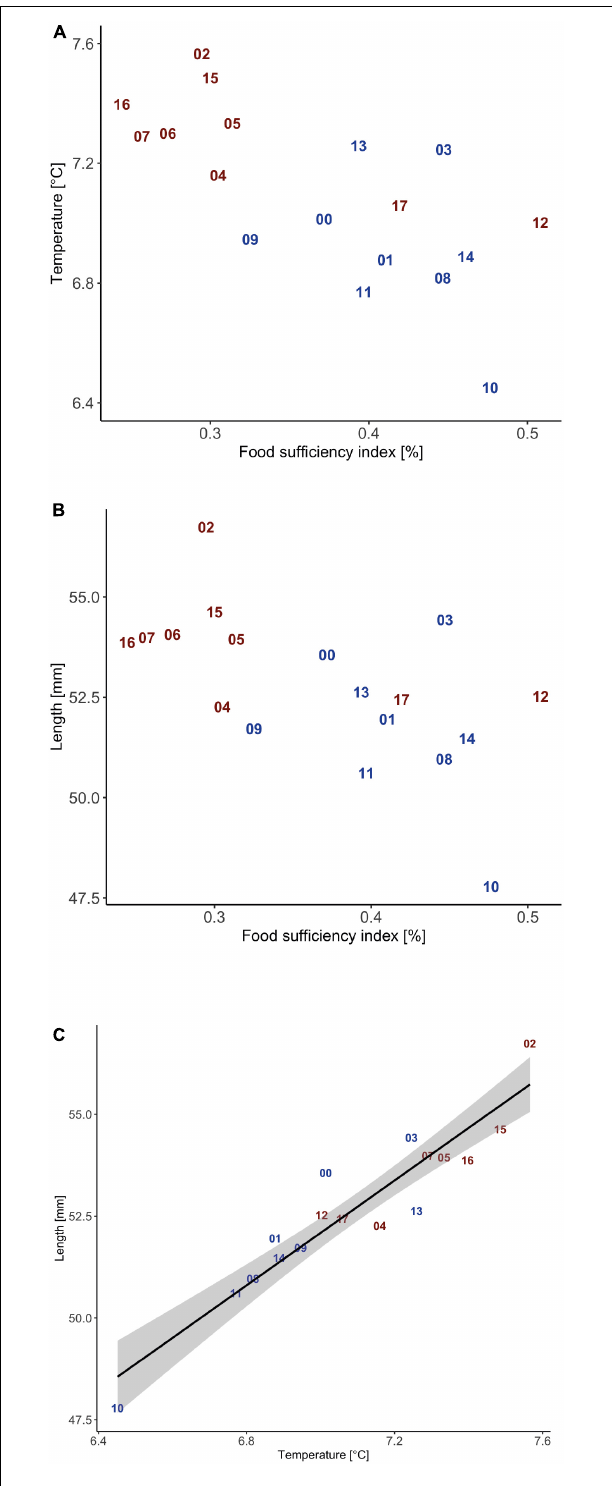
FIGURE 6 | (A,B) Annual mean food sufficiency index weighted by spawning intensity vs. ambient temperature and length also weighted by spawning intensity at September 30th. (C) Annual mean ambient temperature vs. length along with the 95 % confidence interval for the regression. Red are warm years and blue are normal